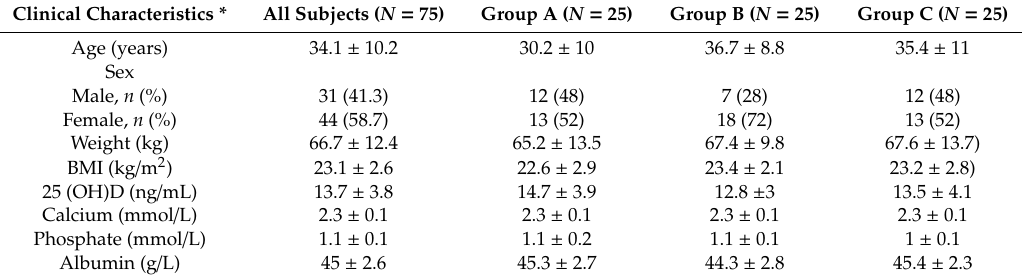
Table 1. Baseline demographic and biochemical characteristics of